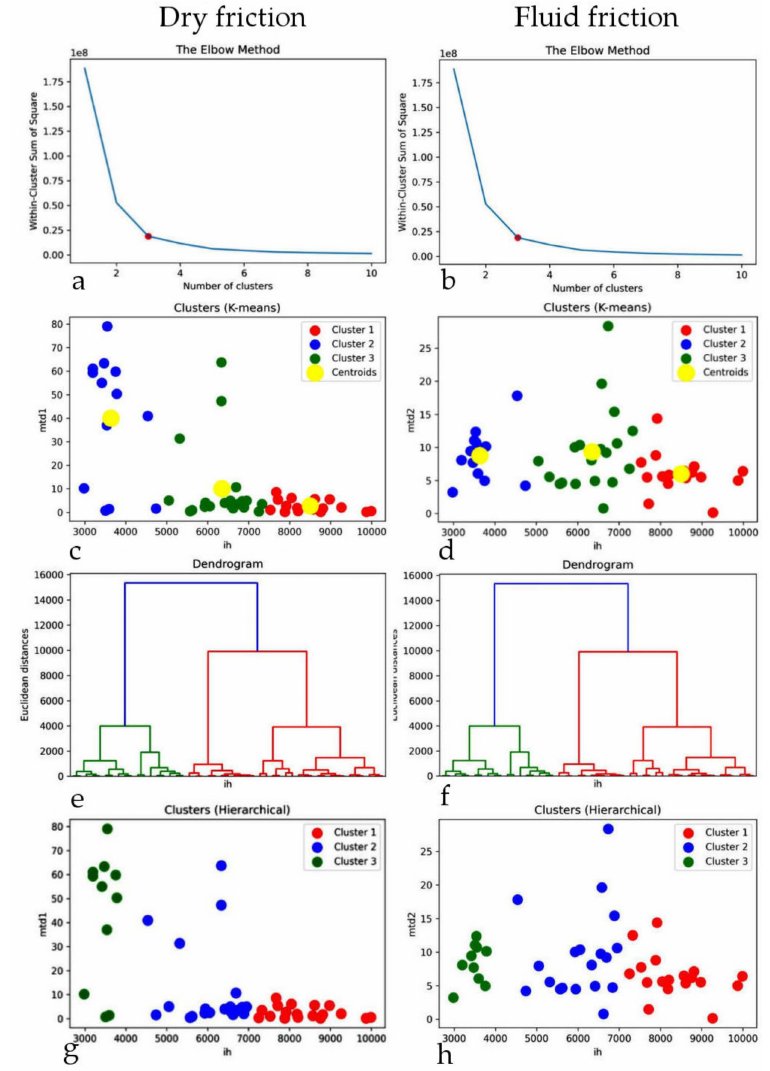
Figure 5. Cluster analysis for dry and fluid friction. Determination of optimal number of clusters using: ( a , b ) Elbow method; ( c , d ) clusters with centroids determined by K-means algorithm; ( e , f ) de- termination of optimal number of clusters for Hierarchical method using dendrograms; ( g , h ) clusters determined by Hierarchical